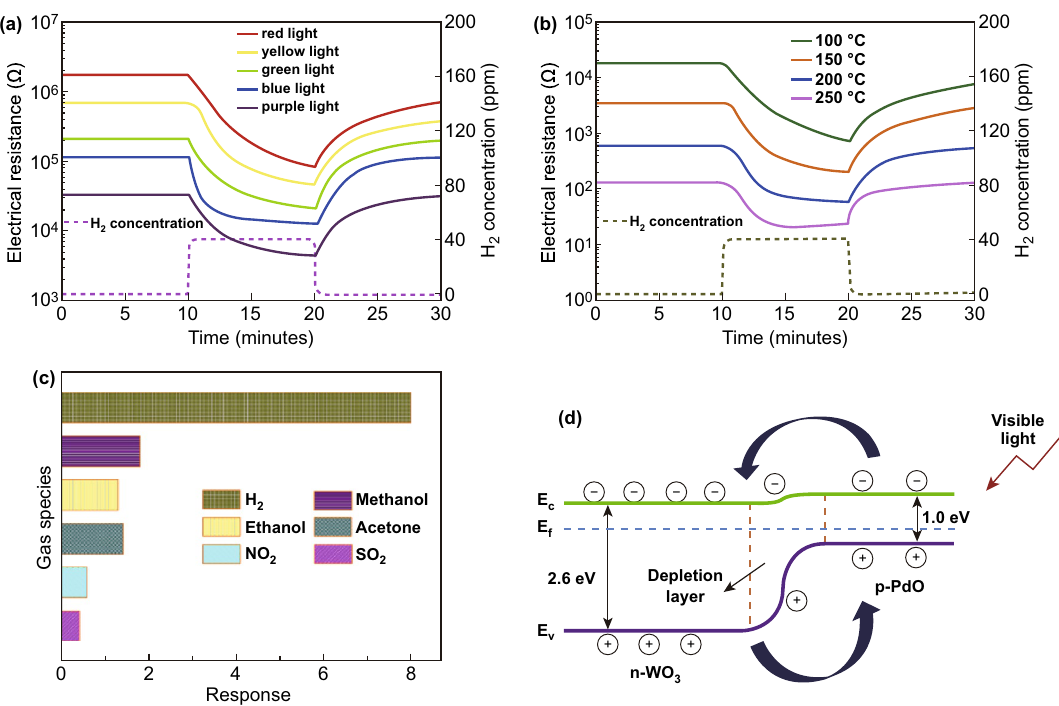
Fig. 8 Resistance variation of the PdO-WO 3 sensor to 40 ppm H 2 at RT under a visible light illumination and b thermal heating at various tem- peratures. c Selectivity of the PdO-WO 3 sensor towards 40 ppm H 2 , 300 ppm acetone, 300 ppm ethanol, 300 ppm methanol, 10 ppm NO 2 and 100 ppm SO 2 under blue light illumination at RT. d Schematic carrier excitation in the PdO-WO 3 nanohybrids under visible light illumination. Reproduced with permission [83]. Copyright 2016,